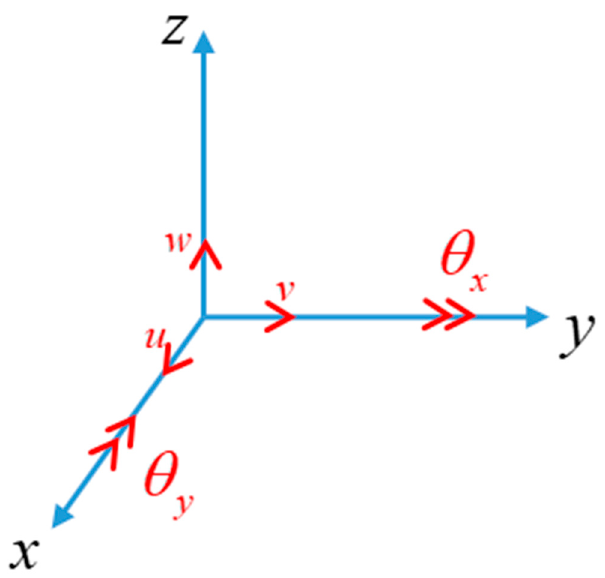
Figure 1. The positive set of the degrees-of-freedom for Mindlin plate formulation.